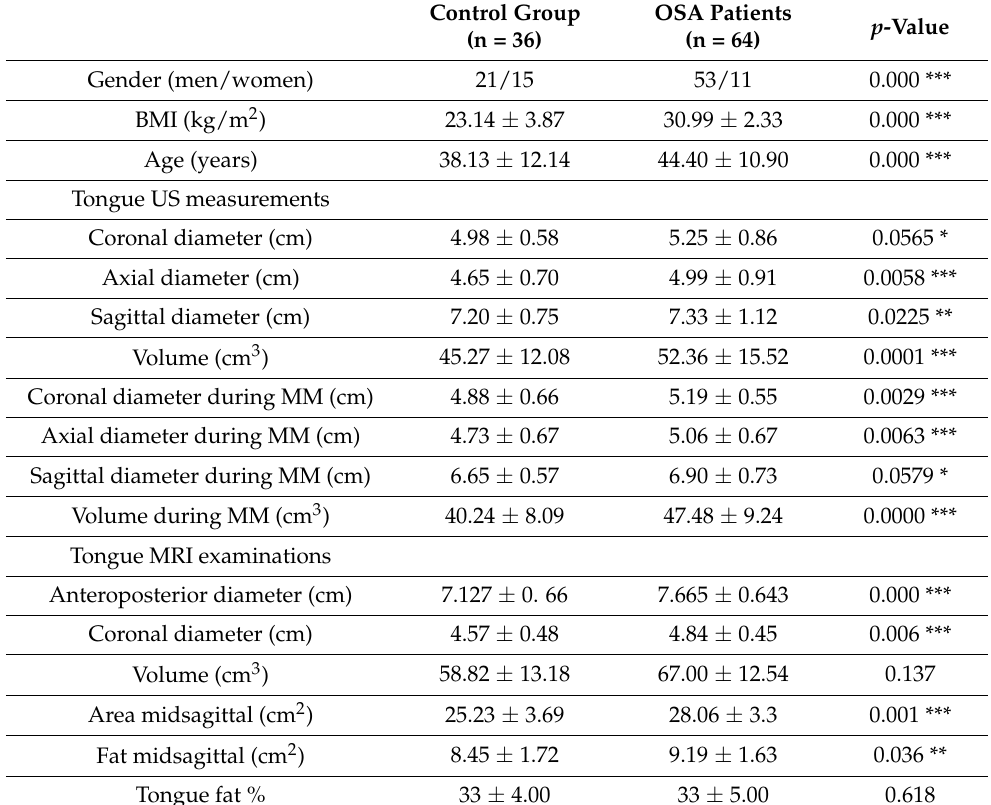
Table 1. Patients’ basic demographic data and US and MRI results according to the AHI classification. The parameters show the mean ± SD values. *** indicates the significant difference at p < 0.01 level, whereas ** the significant difference at p < 0.05 level and * the significant difference at p < 0.1.